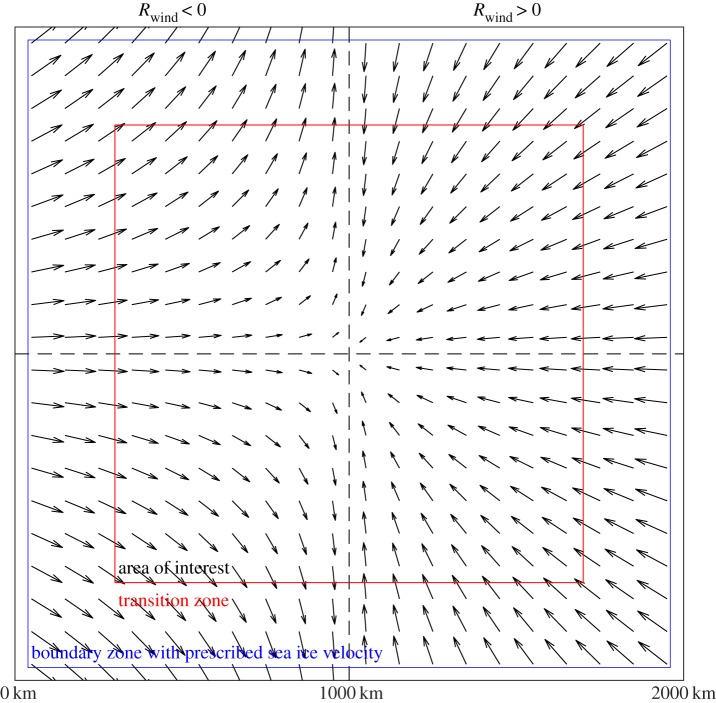
Model domain with two example wind fields. To the left of the figure are flow arrows for a wind with Rwind =  − 0.8 < 0 and the right of the figure with Rwind = 0.8 > 0. The black dashed lines represent the lines of reflectional symmetry in the wind forcing field. The blue square shows dbc, the boundary region with prescribed ice velocity, and the red square shows dtrans, far from the domain boundary within which results are taken from.